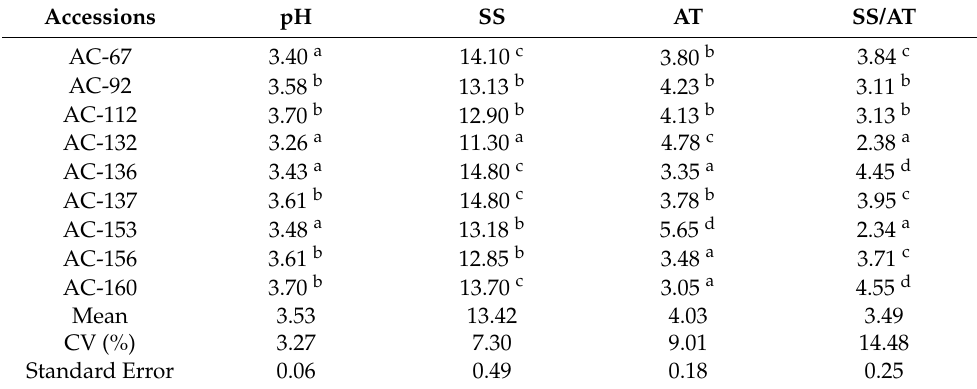
Table 2. Physicochemical characteristics of fruits from nine accessions of Myrciaria floribunda , differ- entiated by their orange, red, and purple